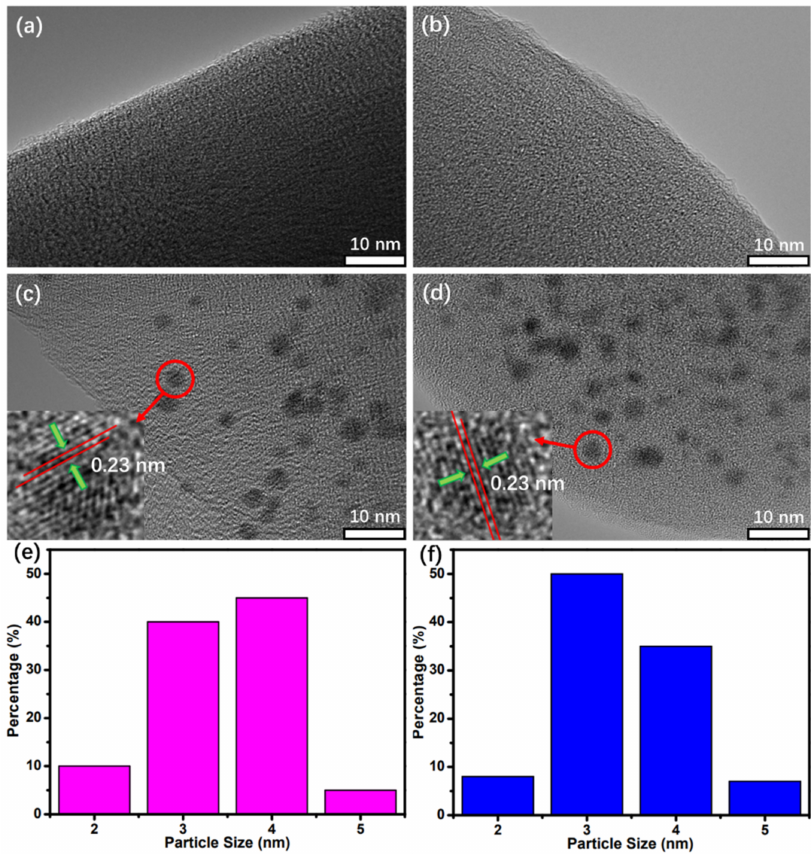
Figure 2. TEM images of PAF-184 ( a ), PAF-185 ( b ), Au@PAF-184 ( c ), Au@PAF-185 ( d ), Au NPs diameter distributions of Au@PAF-184 ( e ) and Au@PAF-185 ( f